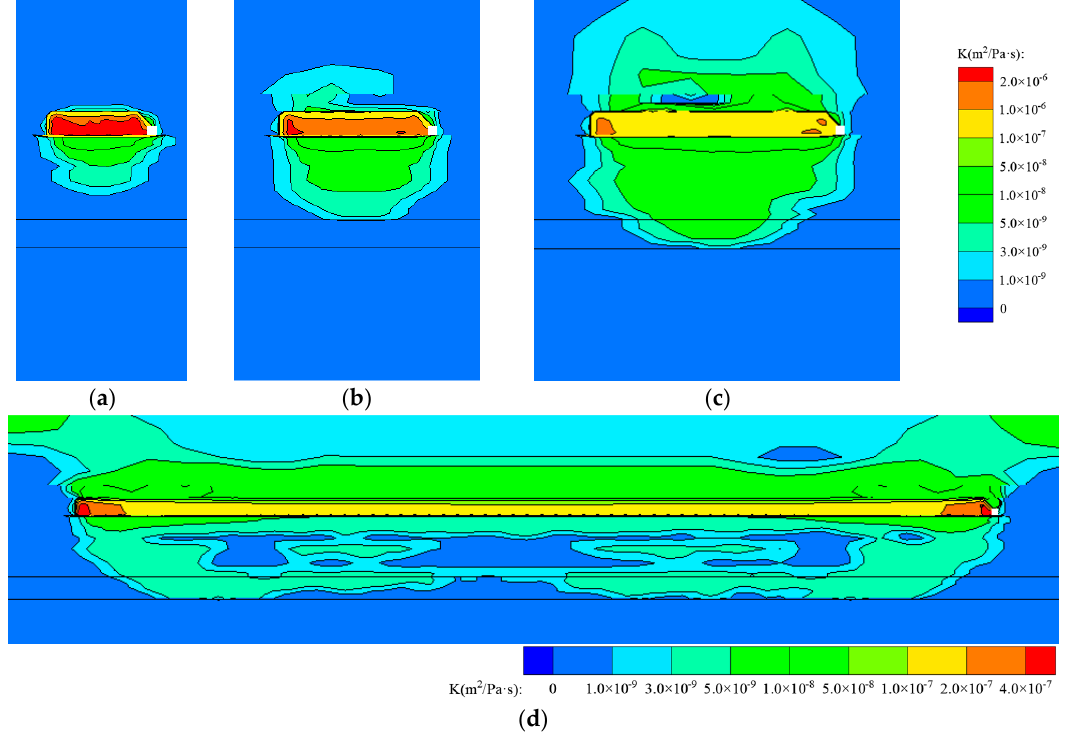
Figure 7. Vertical permeability contour of coal seam and rock with different cumulative advancing lengths; ( a – d ) 20 m, 30 m, 50 m, and 260 m respectively.